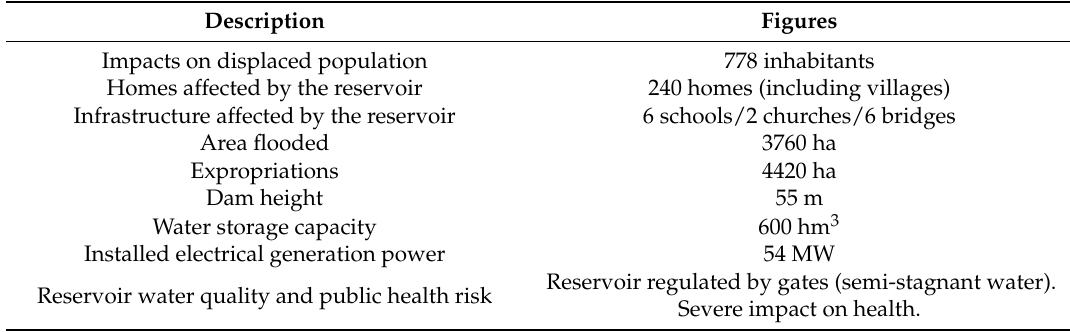
Table 1. Socio-environmental impacts and technical specifications of the original